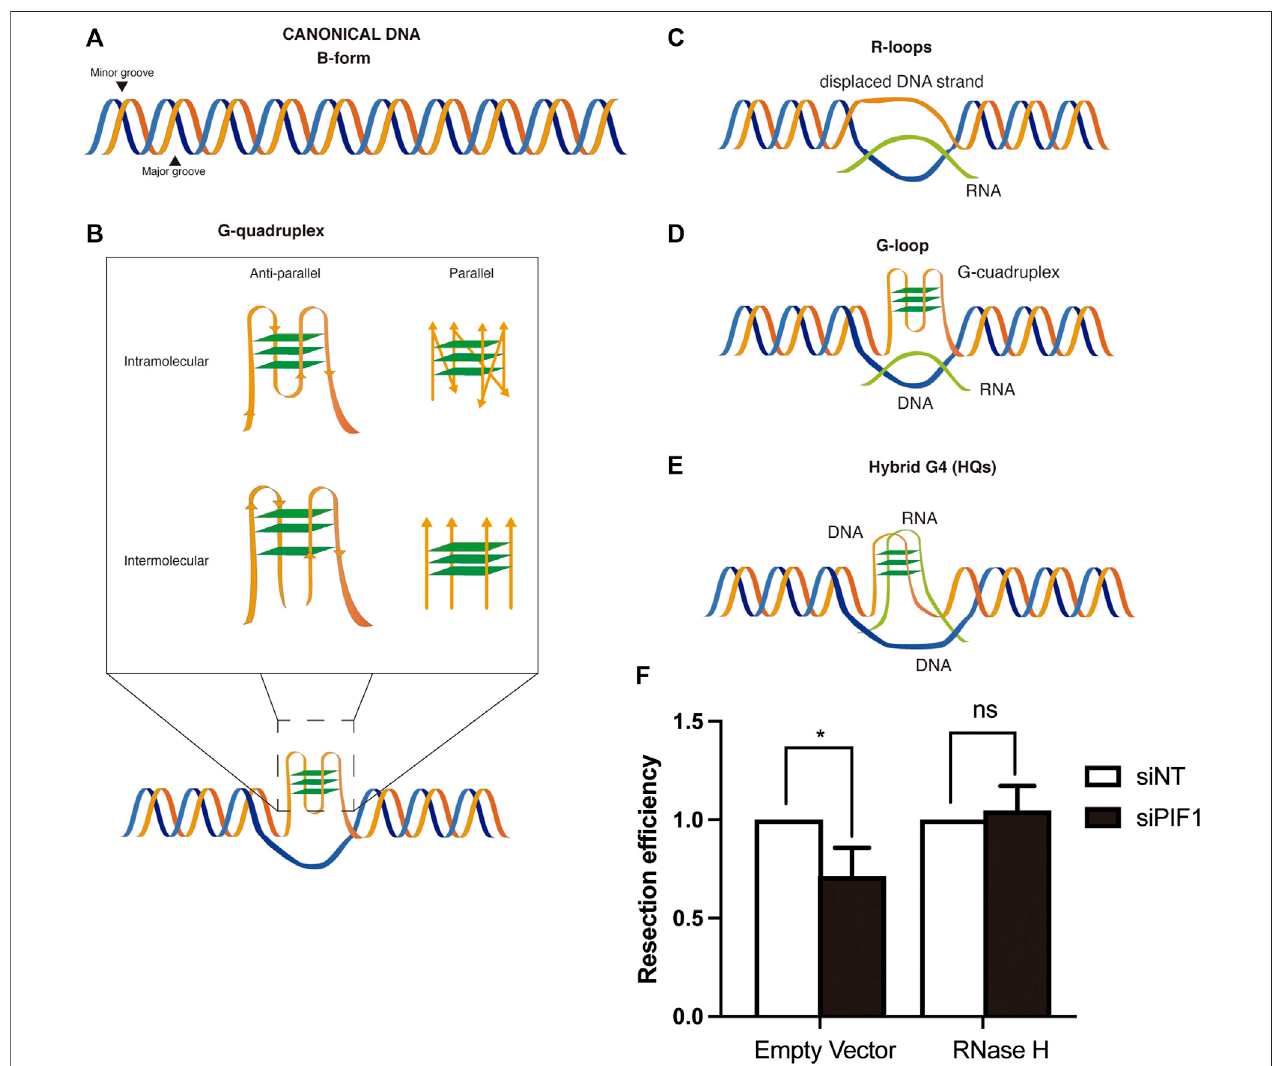
FIGURE 1 | DSB repair and non-canonical DNA structures. (A) Canonical B-form duplex DNA structure. (B) Different conformations of G-quadruplexes. Inset: G-quadruplexmightbeintramolecular(generatedononestrandoftheDNA)orintermolecular(generatedbyseveralstrandsofDNA).Ineachcase,theycanbeparallelor anti-parallel depending on theorientationofthestrands. (C) R-loopsstructuresare formed by the base-paired annealing ofan RNAmolecule with aDNA strand and the consequent displacement its complementary one. (D) G-loops structures arise from the formation of a G4 in the displaced ssDNA strand of an R-loop. (E) Hybrid G4sarechimericstructures inwhichtheG-quadruplexisformed bytheinteraction ofGatboth assDNAandRNAmoleculesofanR-loop,displacingtheotherstrandof the DNA (F) RNase H overexpression rescues the resection defect observed after PIF1 depletion. DNA resection pro fi ciency measured as the percentage of RPA-foci- positive U2OS cells in cells expressing FLAG-RNase H or a FLAG empty vector and with either an siRNA against PIF1 (Dharmacon, CAUAUCUGCUAAAGCGAAU) or controlsiNT.Brie fl y,cellswereseededandgrownfor24 honcoverslips.Thedayoftransfection,mediumwasreplacedbyfreshDMEMwithoutantibioticsandcellswere incubated with a mix of siRNA and Lipofectamine diluted for 6 h in Opti-MEM before transfection with the plasmids with FuGENE six Transfection Reagent (Promega). 48 h after siRNA transfection, cells were irradiated (10 Gy) and incubated at 37 ° C for 1 h. Coverslips were then washed once with PBS followed by treatment with pre- extraction buffer (25 mMTris-HCl, pH 7.5, 50 mMNaCl, 1 mM EDTA, 3 mM MgCl2, 300 mM sucrose and 0.2% Triton X-100) for 5 min on ice. Cells were fi xed with 4% paraformaldehyde(w/v)inPBSfor15 min.FollowingtwowasheswithPBS,cellswereblockedfor1 hwith5%FBSinPBS,co-stainedwithanti-RPA(Abcamab2175)andanti- Y H2AX (Cell Signaling 2,577) antibodies in blocking solutionovernight at 4 ° C, washed again with PBS and then co-immunostained with the appropriate secondary antibodies (AlexaFluor594goatanti-mouse(InvitrogenA-11032),AlexaFluor488goatanti-rabbit(InvitrogenA-11034)inblockingbuffer.AfterwashingwithPBSanddriedwithethanol70 and 100% washes, coverslips were mounted into glass slides using Vectashield mounting medium with DAPI (Vector Laboratories). RPA foci immuno fl uorescences were analyzedusingaLeicaFluorescencemicroscopewithaHCXPLAPO63x/1.4OILobjective.Inallcases,atleast200cellswereanalysedperconditionandtheexperimentswere replicated independently at least three times. Signi fi cance was determined by Student ’ s t test comparing each condition to siNT cells. * p < 0.05.